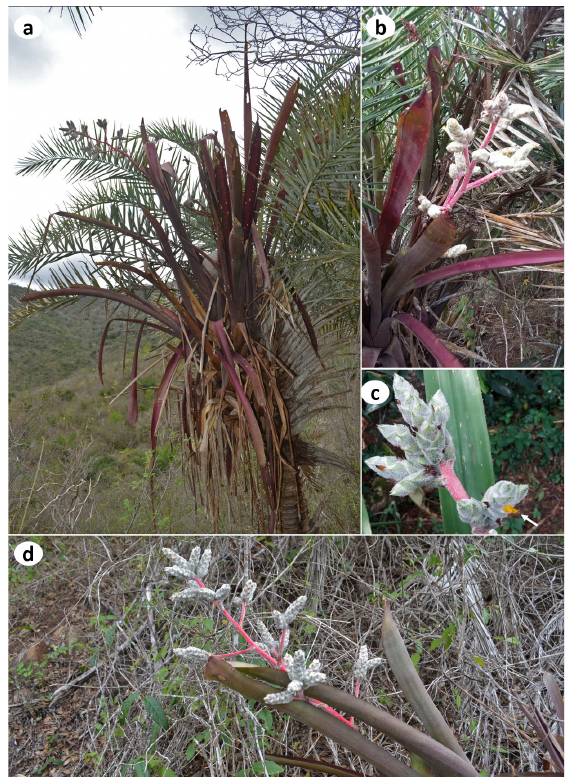
Figure 1. Hohenbergia lanata . a) An epiphytic population in full bloom. b) A blooming plant. c) Details of the upper portion of the inflorescence, showing branches and one flower in anthesis (arrow). d) A terrestrial plant and inflorescence in